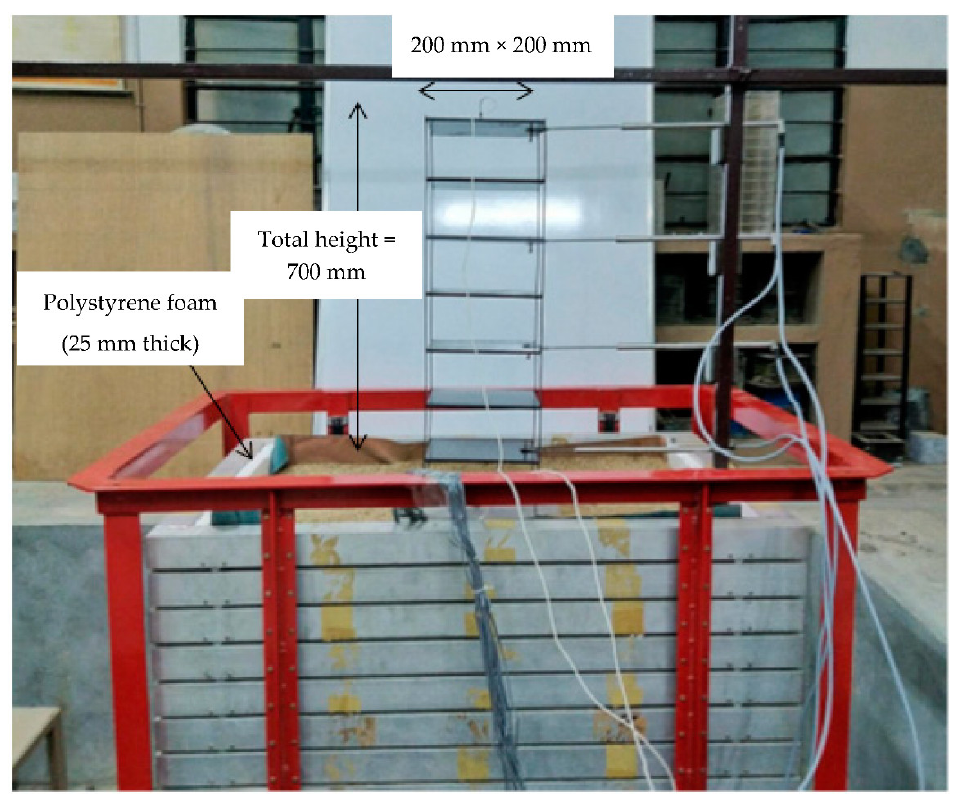
Figure 5. Shake-table test for the fixed-base structure.